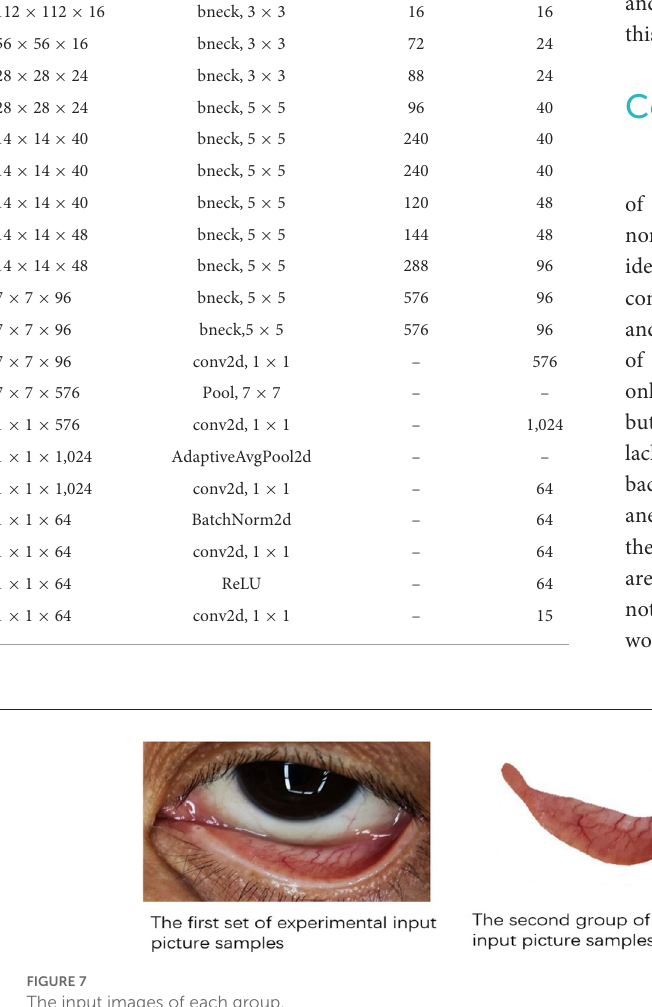
FIGURE7 The input images of each